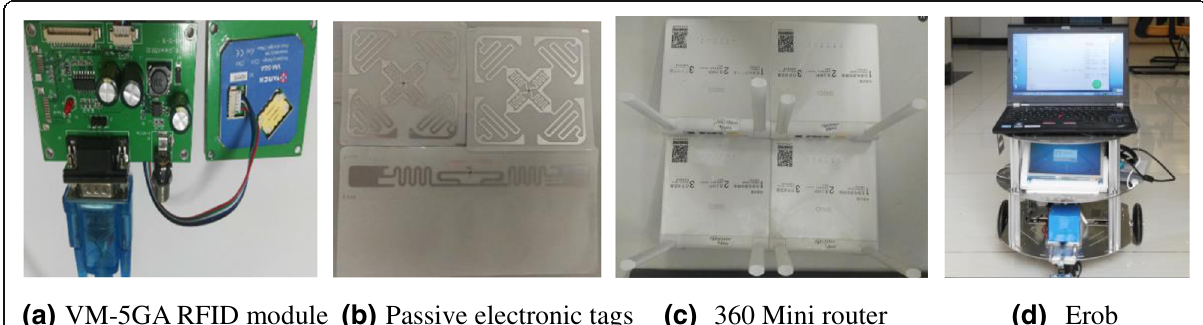
Fig. 5 Part of the experimental equipment. a VM-5GA RFID module — RSS signal for collecting electronic tags. b Passive electronic tags — provide RSS signal for reader. c 360 Mini router — provide AP ’ s RSS signal for laptop. d Erob — self-developed educational robot, it is a mobile platform